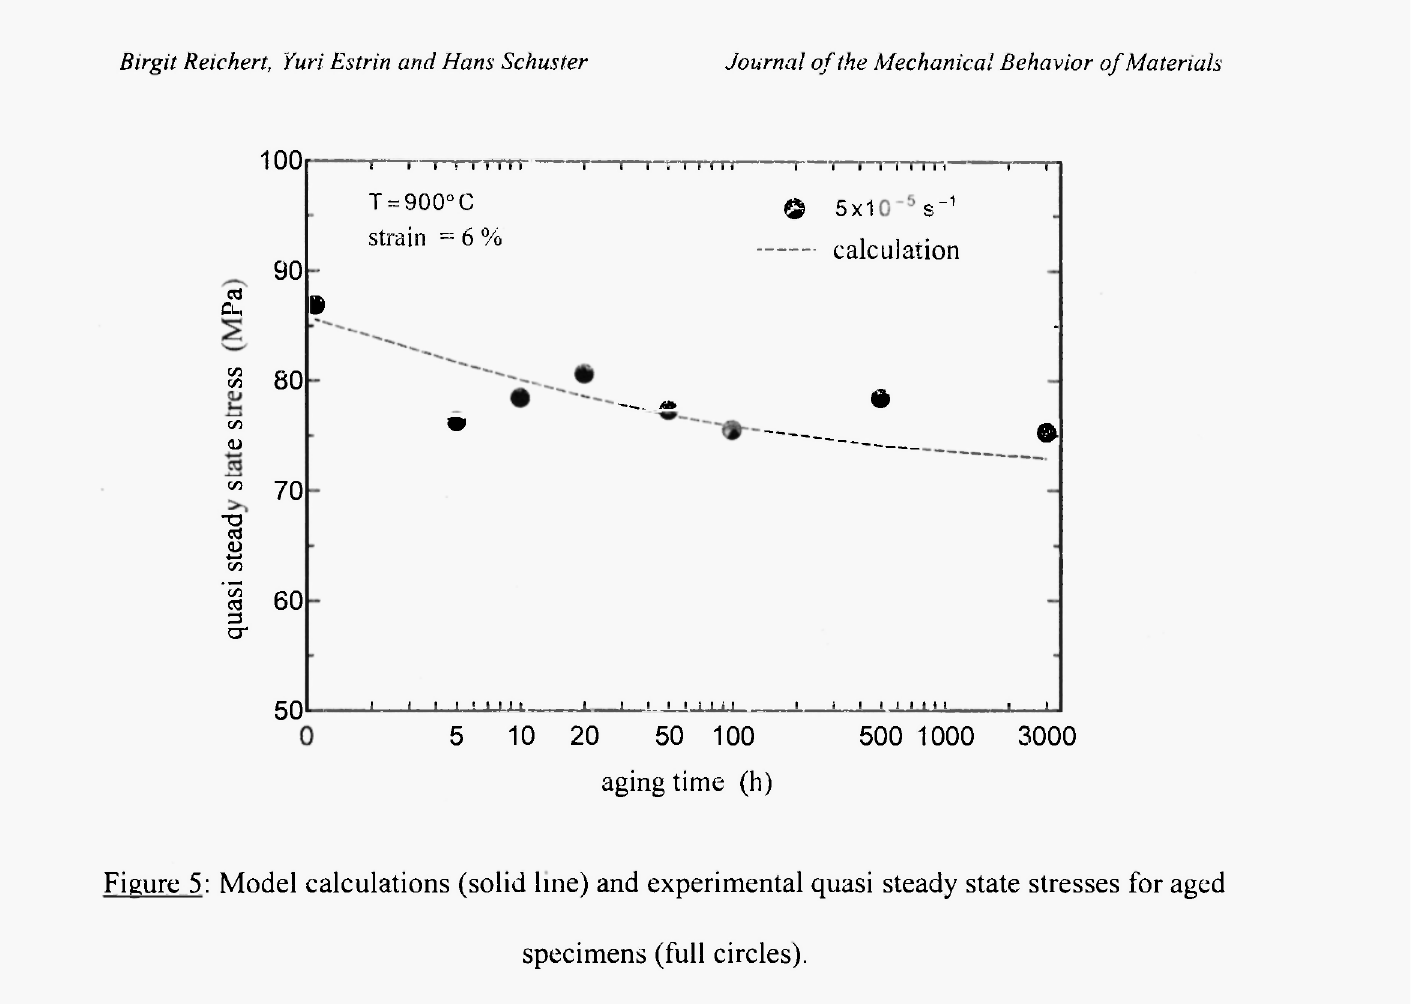
Figure 5: Model calculations (solid line) and experimental quasi steady state stresses for aged specimens (full